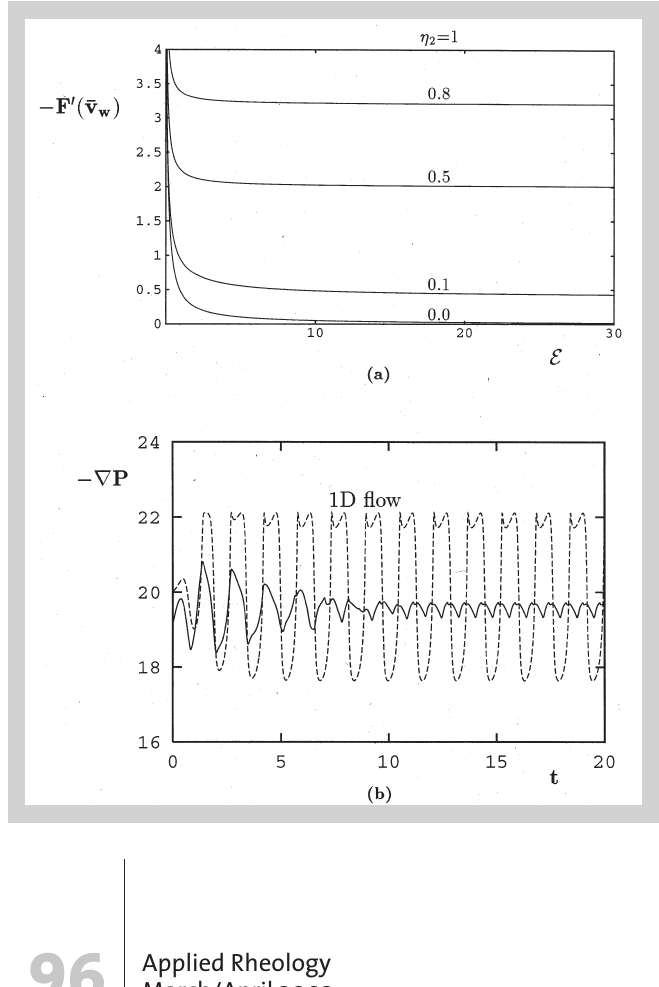
Figure 5: (a) Linear stability diagram for the Poiseuille flow of an Oldroyd-B fluid with slip at the wall and constant volumetric flow rate; solutions above the corresponding marginal stability curve up to -F’(v– w ) = 4 are unstable; (b) Pressure-drop oscillations in two-dimen- sional Poiseuille flow and comparisons with the one-dimensional calcula- tions (broken line); Q = 0.45, Re = 1, We = 1, and h 2 =